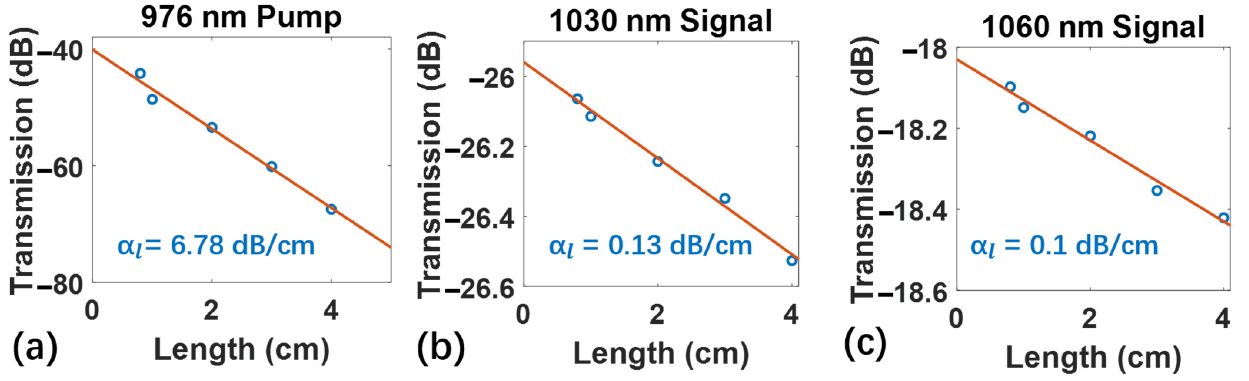
Figure 4. The measured loss curve of the pump light at ( a ) 976 nm, the signal light at ( b ) 1030 nm, and ( c ) 1060 nm.